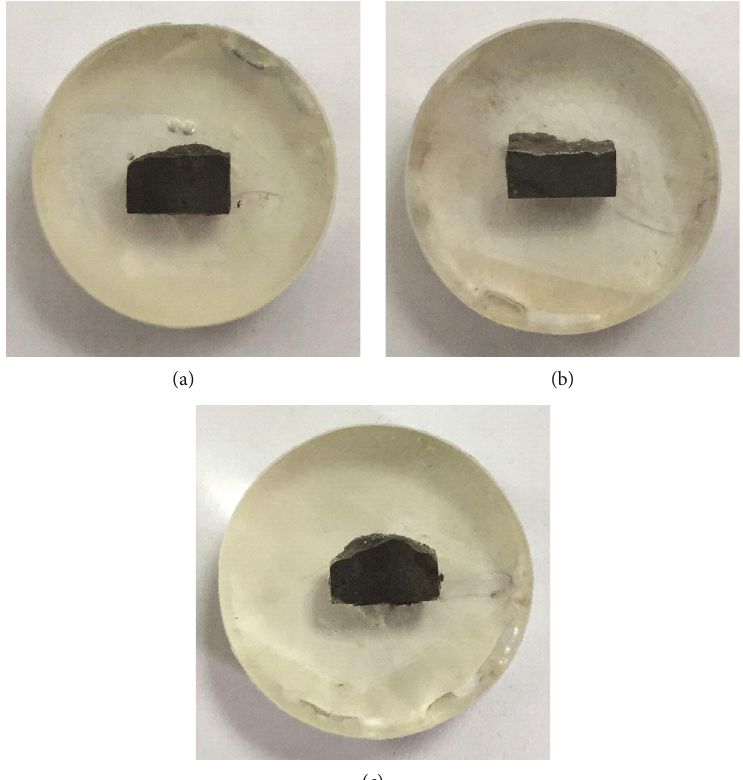
Figure 4: Well-prepared specimens: (a) NM-1, (b) NM-2, and (c) NM-3.